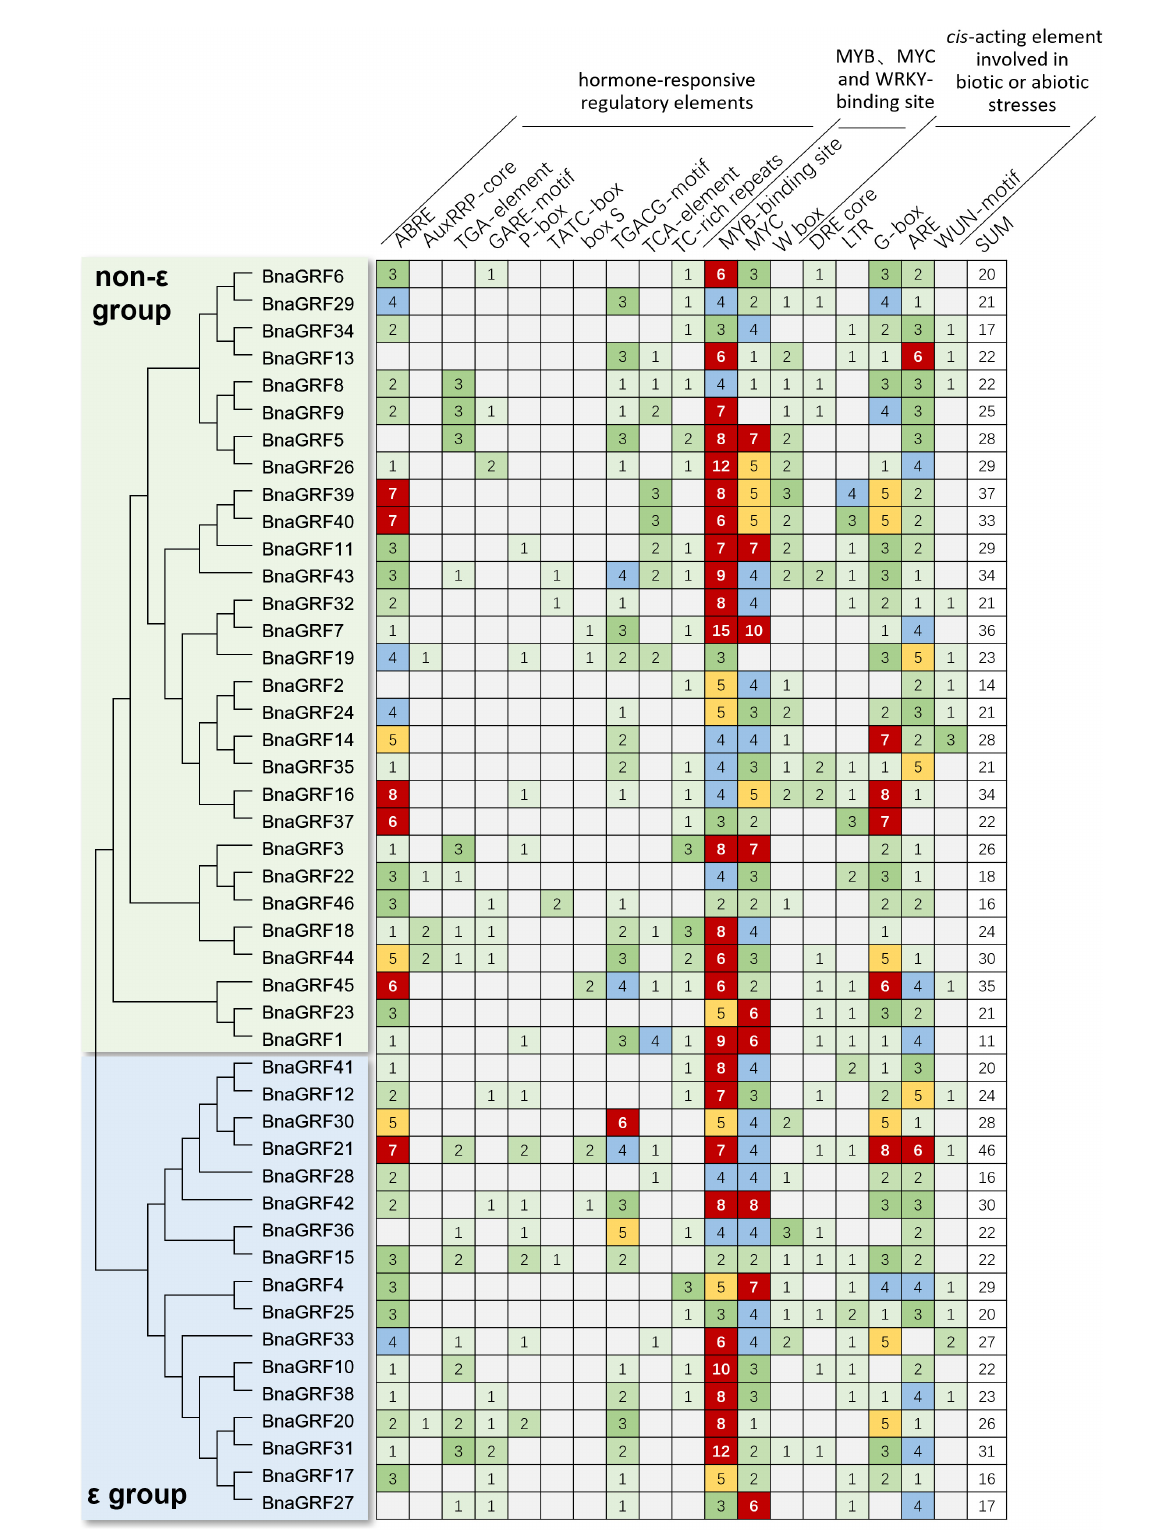
FIGURE5 Number of hormone- and stress-responsive cis -elements in the promoters of the BnaGRFs .